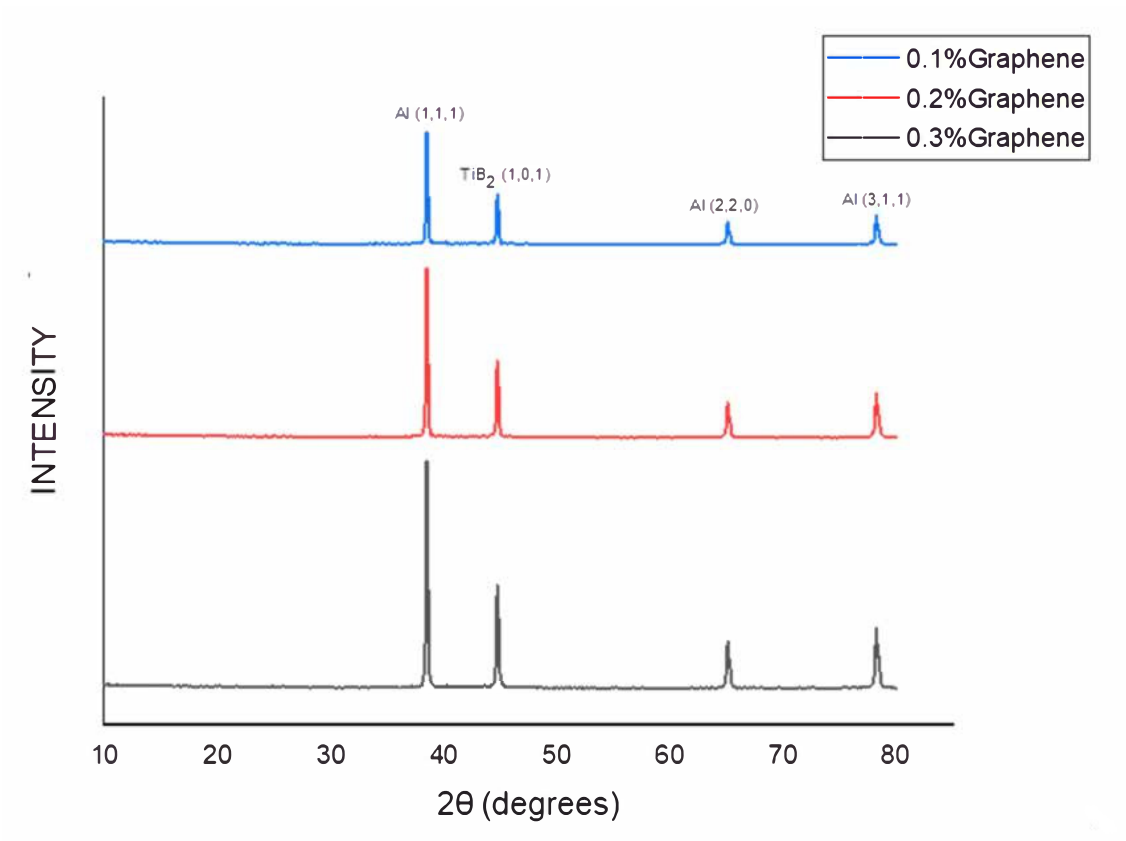
Figure 4. XRD results for various proportions of graphene.